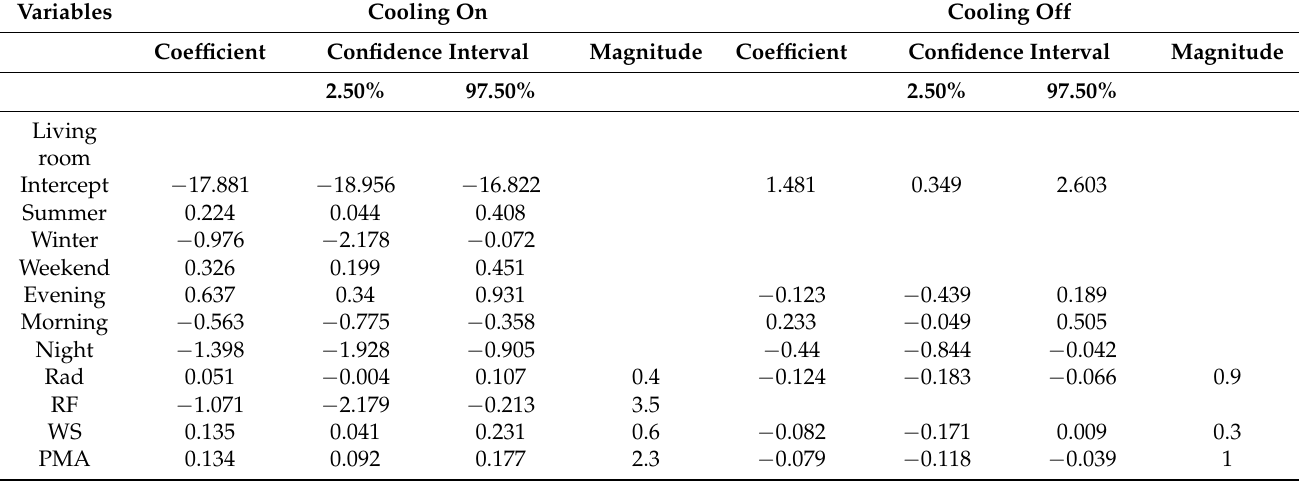
Table 7. Coefficients and magnitudes of variables inferred from cooling on and off